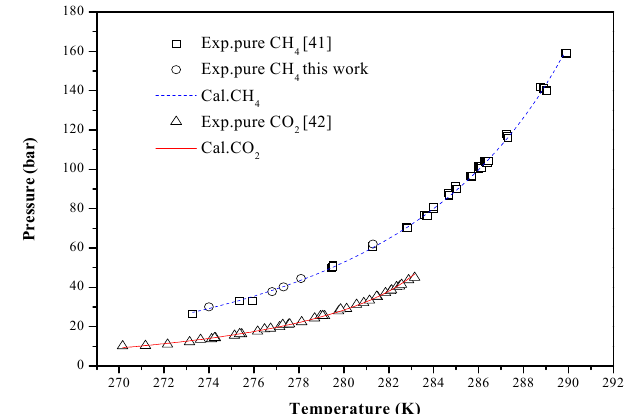
Figure 6. Experimental and predicted phase equilibrium conditions for CH 4 /CO 2 + water systems. Sloan [41], squares □ ; Ma et al. [42], triangles ∆ ; this work, circles . (cid:35)